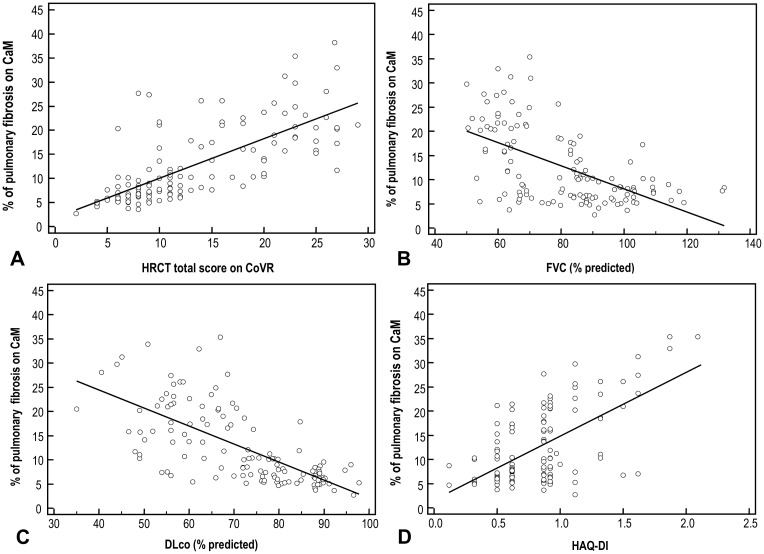
Scatter plots with regression line.(A) Correlation between computer-aided method (CaM) system for quantification of ILD on HRCT in SSc and the conventional visual reader-based score (CoVR). (B) Correlation between percentage of pulmonary fibrosis on CaM system and FVC, % predicted. (C) Correlation between percentage of pulmonary fibrosis on CaM system and DLco, % predicted. (D) Correlation between percentage of pulmonary fibrosis on CaM system and HAQ-DI.